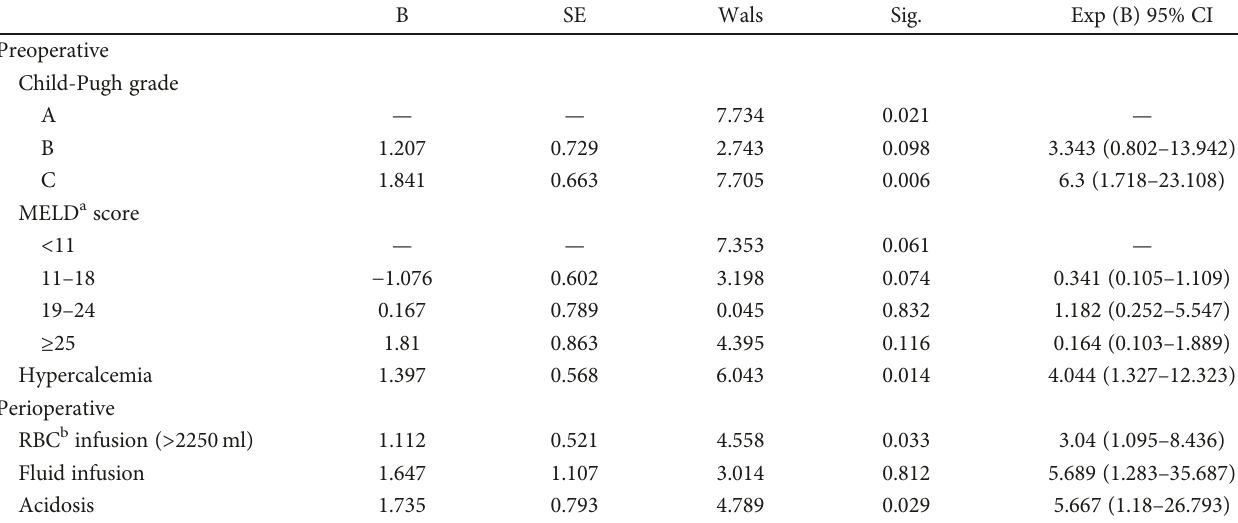
Table 7: Univariate logistic analysis for the incidence of sepsis after orthotopic liver transplantation (OLT) (reported as n (%), unless otherwise noted).